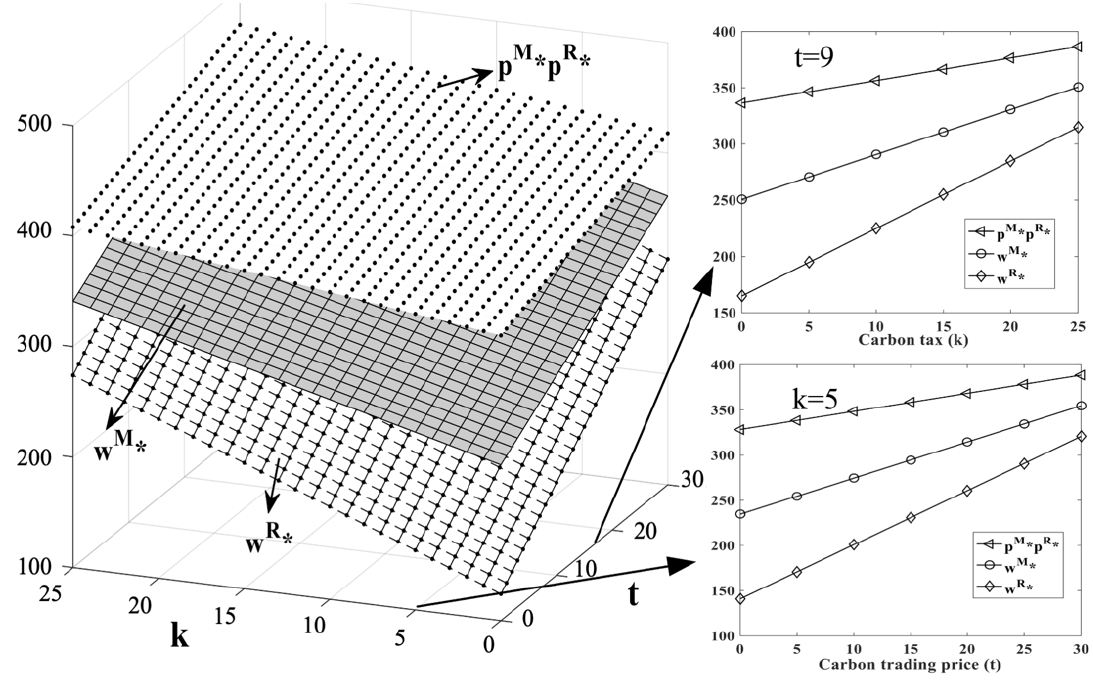
Figure 3. Changes of 𝑝 and 𝑤 regarding 𝑡 and 𝑘 .